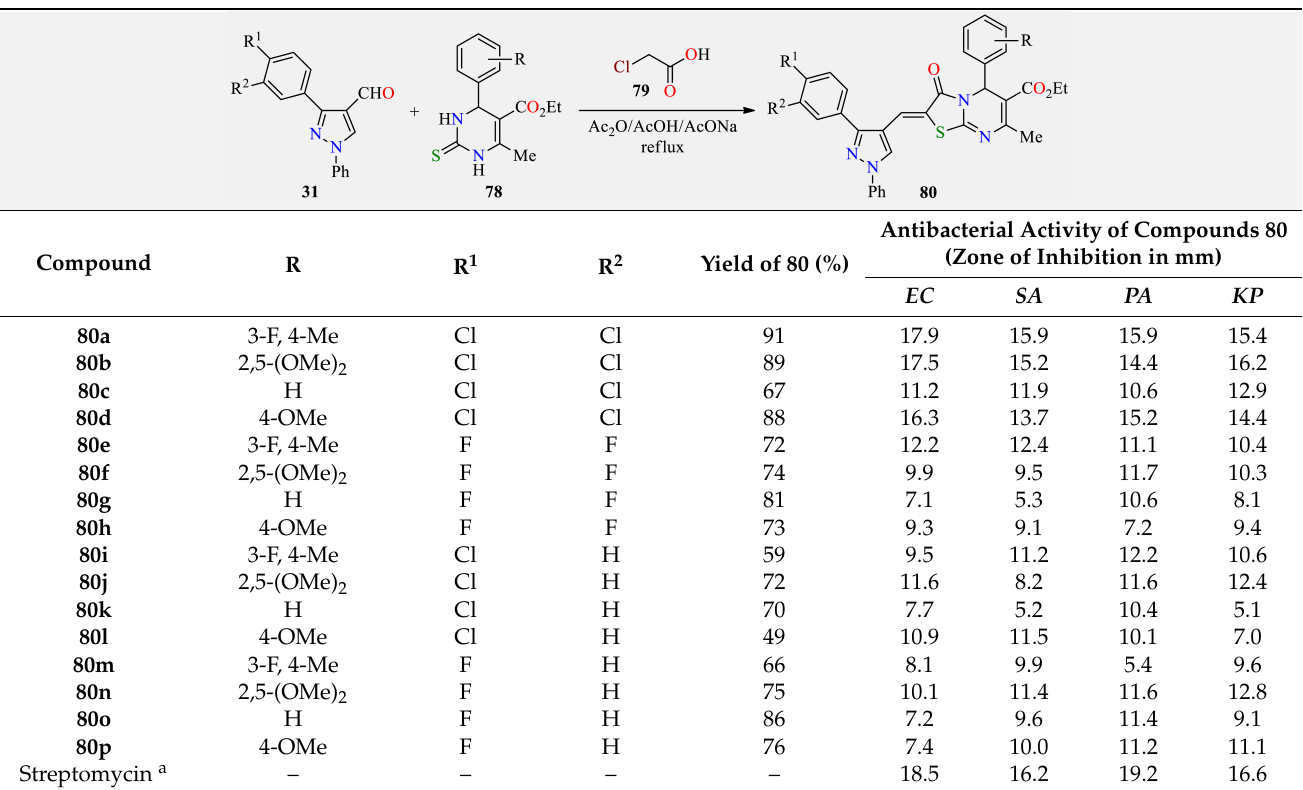
Table 19. Three-component synthesis of thiazolo[2,3- b ]dihydropyrimidinones 80 and their in vitro antibacterial activity against four bacterial